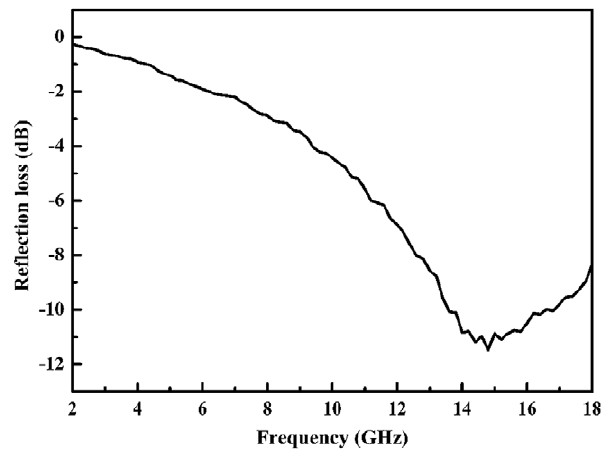
Figure 6. Absorbing ability of chain-like Co flower at 2 mm